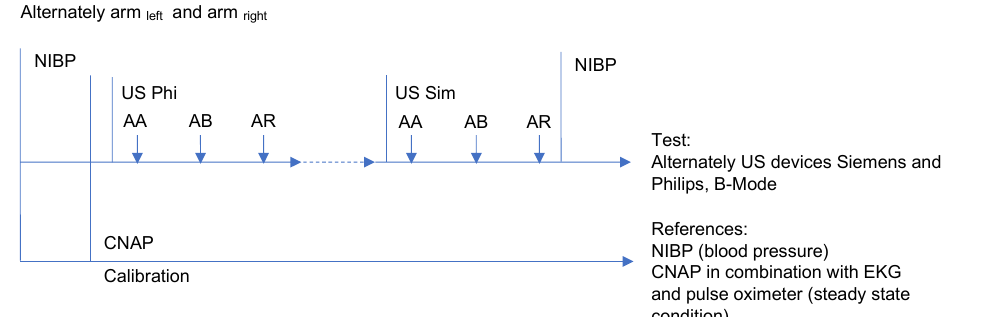
Figure 1. Test protocol of the examination of each subject with essential requirements: (1) Blood pressure is constant. (2) Reference monitor for steady state conditions (CNAP) is on the same arm. (2) Alternate measurements on the left and right arms. (3) Data recording of ECG, pulse oximeter, and CNAP blood pressure curves in near real time.